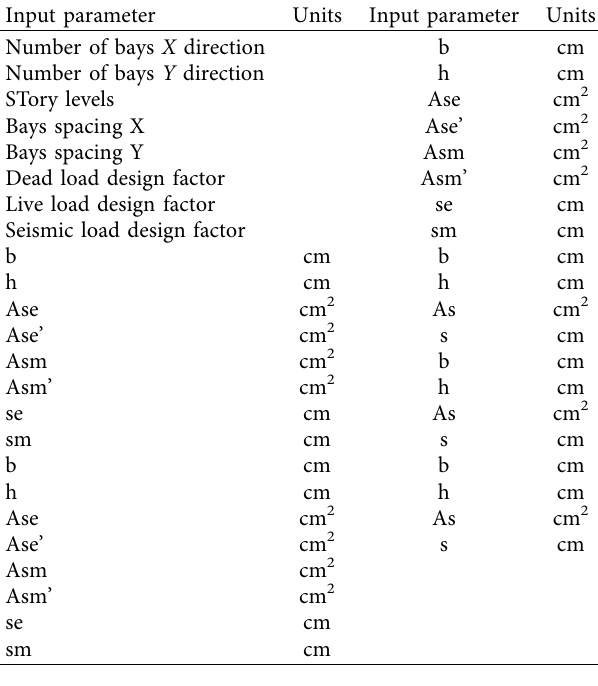
Table 5: Input vector of the second ANN model.